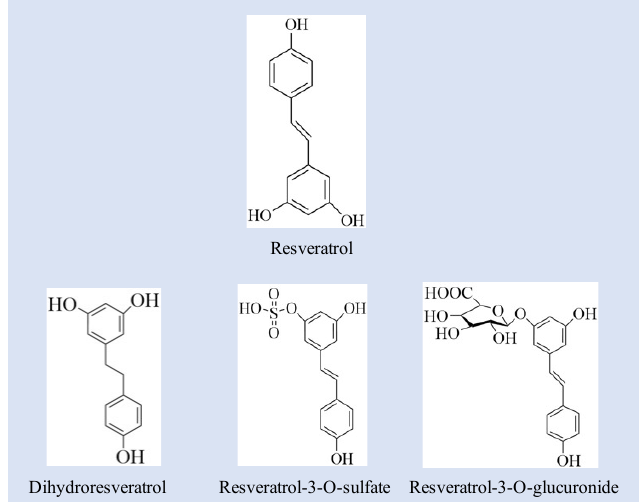
Figure 1. The structures of resveratrol and related metabolites including dihydroresveratrol, resveratrol-3-O-sulfate, resveratrol-3-glucuronide.